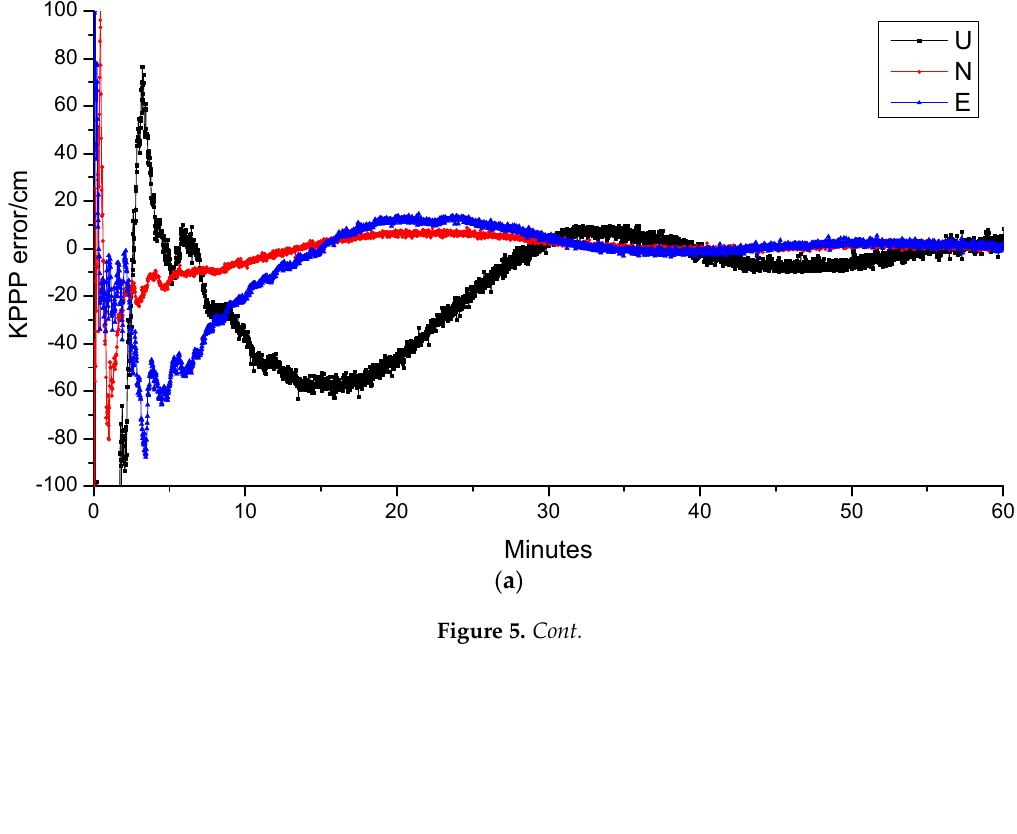
Table 7. SPP precision of both BDS and BDS + LEO (cm).